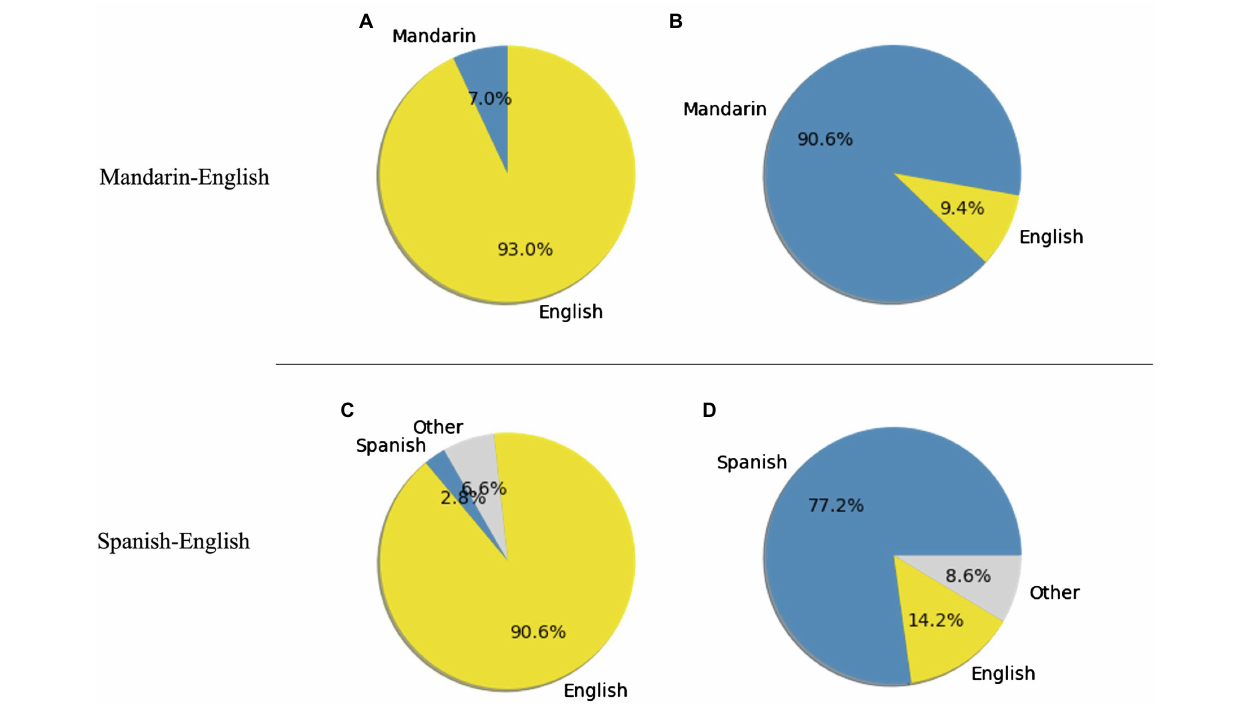
FIGURE 3 | Proportions of words within each community in Mandarin-English (A,B) , and Spanish-English (C,D) . Networks are based on all sentences and word2vec embeddings. For the Spanish-English plots, “Other” represents words with ambiguous language identities.